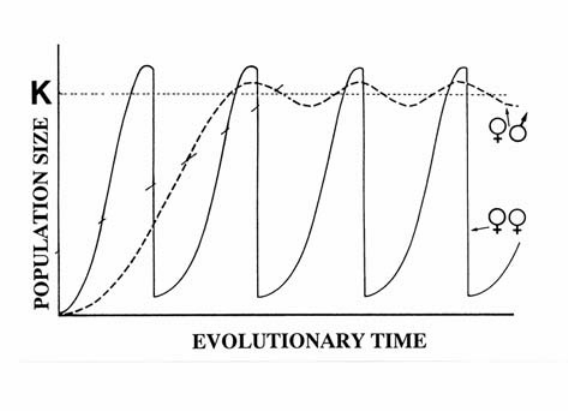
Figure 15. Theoretical curves representing the difference between sexual (dotted line) and parthenogenetic (solid line) population fluctuations in nature. The beginning of each curve, up to line K (carrying capacity), represents the growth rate during the invasion of new habitats. Thereafter, sexual populations fluctuate close to K, whereas the parthenogenetic populations fluctuate radically, overshooting K between catastrophes due to a high rate of increase, and crashing to a low level during catastrophes (adapted from Cuellar - 6).